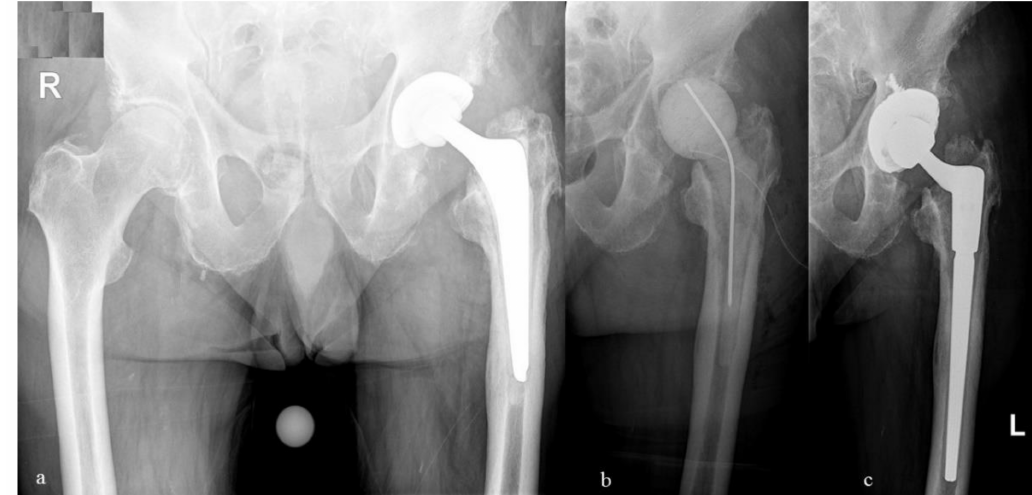
Figure 5. ( a ) Anterio-posterior radiographs of the pelvis of an 86-year-old man with a septic loosening of the femoral stem; ( b ) Following prosthesis explantation, an articulating spacer was inserted into the femur; ( c ) After an interim period of 69 days, the prosthesis reimplantation was performed with cementless implants (Restoration Acetabular Shell ® , Restoration Stem ® , Fa. Stryker, Duisburg, Germany).